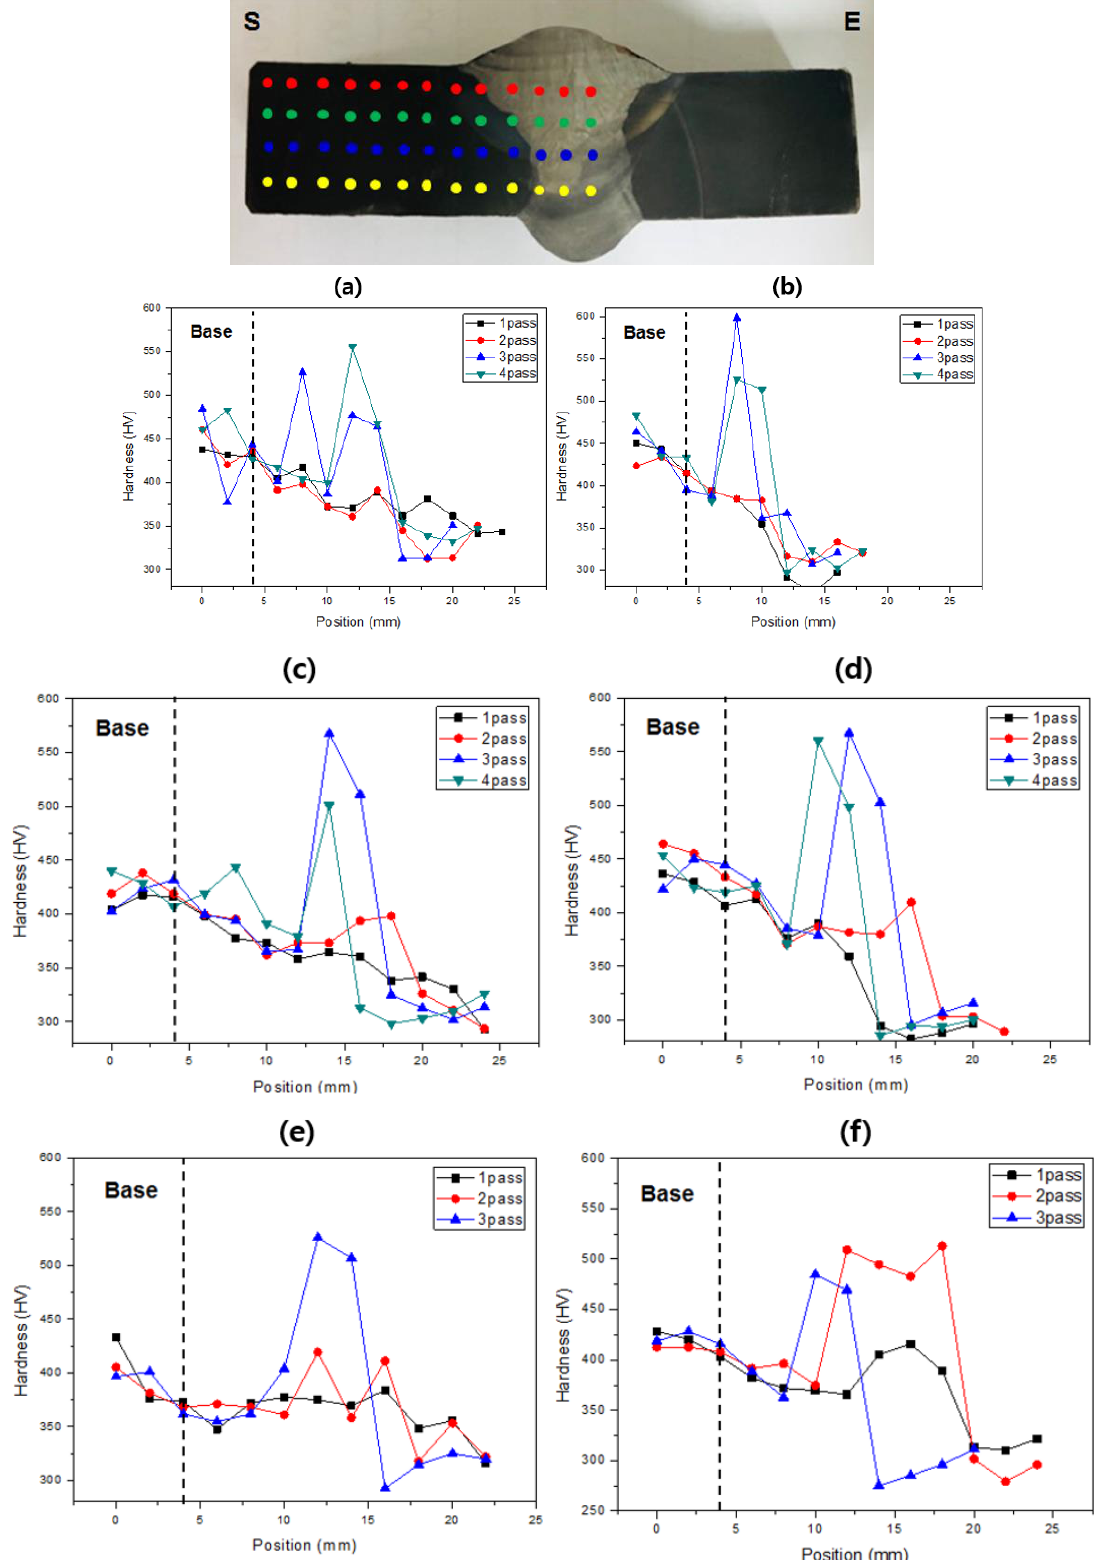
Figure 8. Hardness analyses of GMAW with CO 2 5% and 20% shielding gas and heat input in butt joint: ( a ) 05L; ( b ) 20L; ( c ) 05M; ( d ) 20M; ( e ) 05H; ( f ) 50H.